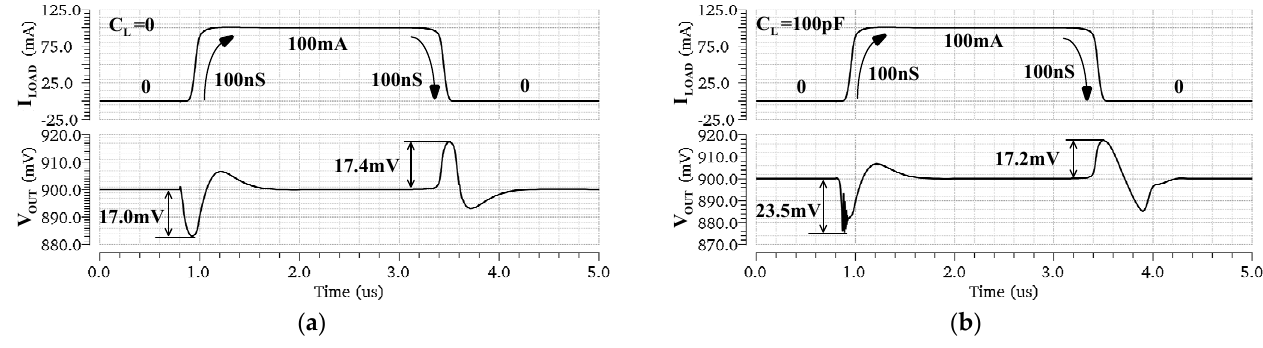
Figure 9. Simulated load transient response of the proposed OCL − LDO regulator for a load current switched between 0 and 100 mA with an edge time of 100 ns. ( a ) C L = 0, ( b ) C L = 100 pF.